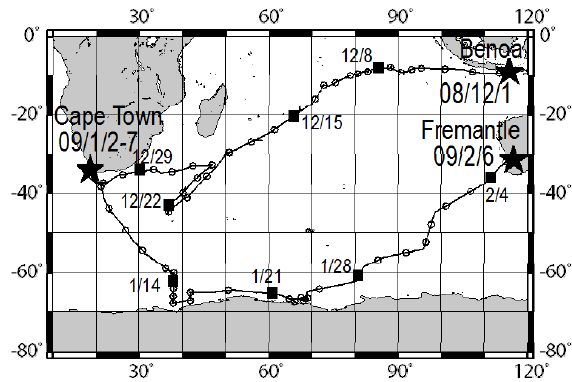
Figure 1. Ship tracks of the TR/V Umitaka-maru UM-08-09 cruise. Open circles and black squares represent noon of each day at local